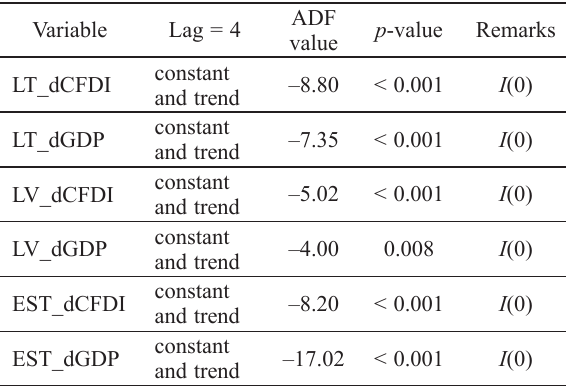
Table 4. Test results of ADF